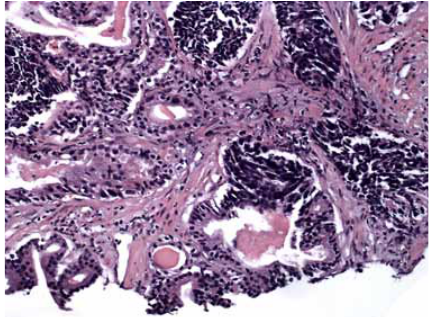
Figure 1 - Low power of small cell carcinoma (left) associated with Gleason 8 acinar adenocarcinoma (right). Hematoxilin- eosin, 40x.